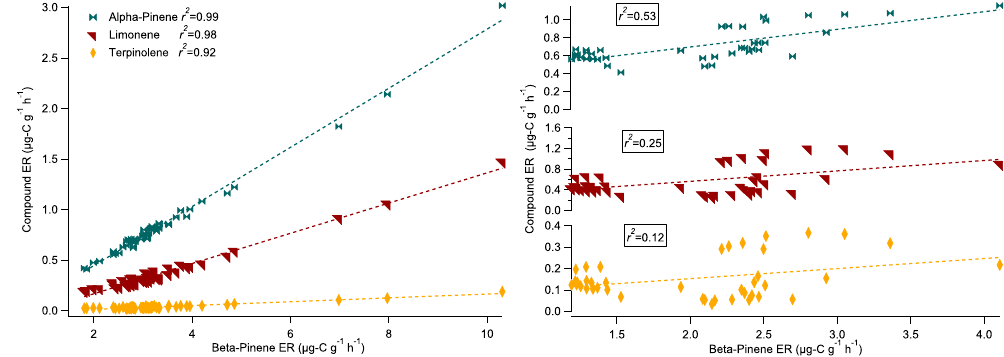
Figure 10. Scatterplots of the constitutive emissions alpha-pinene, limonene, and terpinolene vs. beta-pinene (the dominant constitutively emitted compound during the pre-treatment period) during experiment AG-E. Pre-treatment values are plotted on the left and post-treatment values are plotted on the right. Results of the linear regression analysis are included on the graphs.